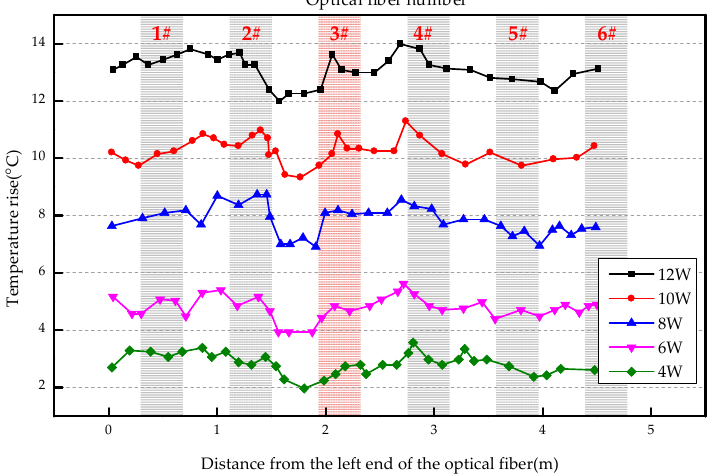
Figure 9. Temperature increase curve of seepage flow velocity at 100 mm/h.